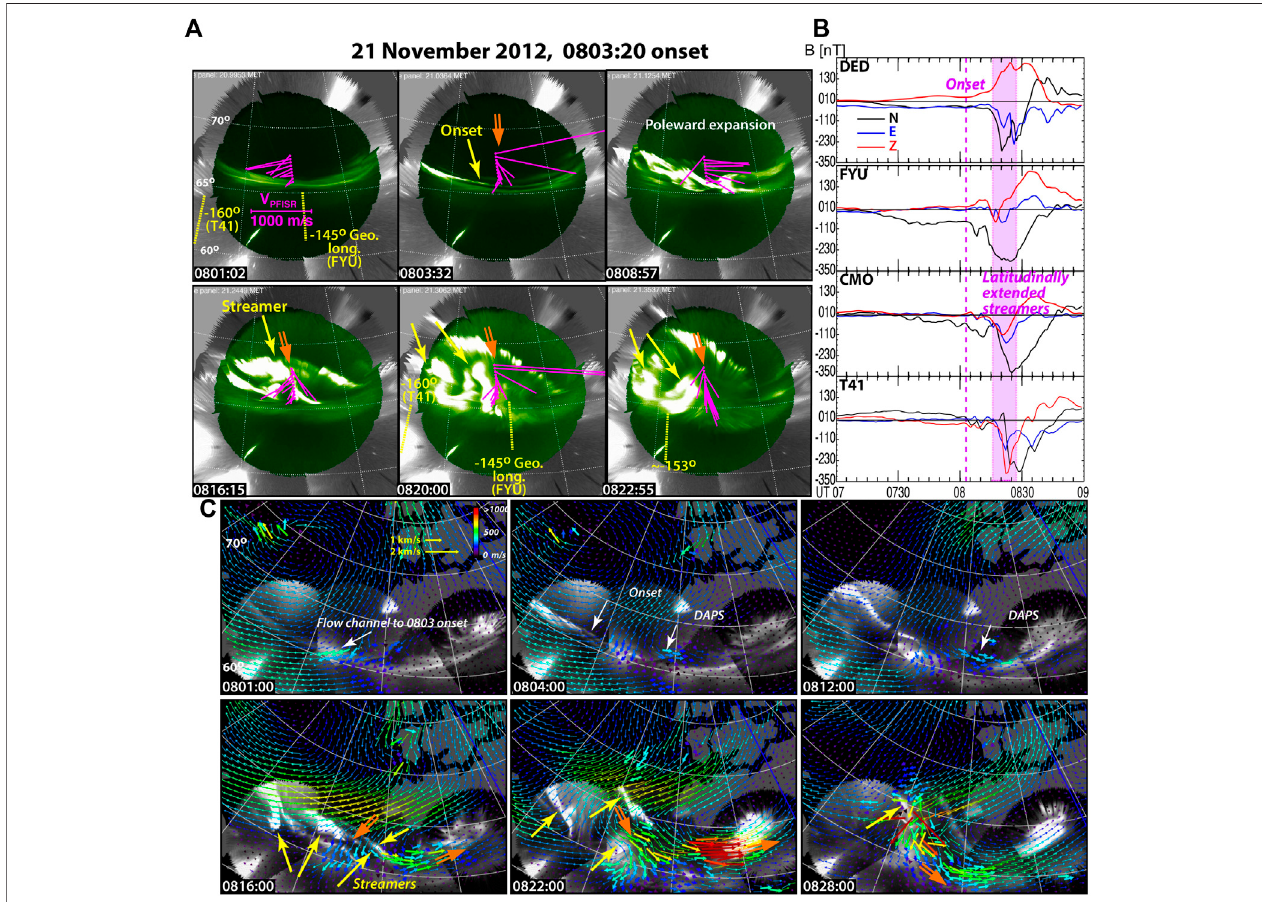
FIGURE7| Observations onNovember21,2012,duringaperiod whenPFISRwasoperating, andthereweresuf fi cientSuperDARNechoesavailableinregionsof interesttoprovide sometwo-dimensional fl owcoverage. (A) Poker FlatASI557.7 nm emissionswithTHEMIS ASIwhitelightemissions in regionsoutside thePoker Flat ASI FOV overlaid with PFISR fl ow vectors along the radar magnetic meridian. (B) Ground magnetometer observations from stations approximately along the Poker Flat meridianstackedfromlowertohigherlatitudes. (C) THEMISASImosaicsoveralargerareaoverlaidwithSuperDARN fl owvectors.Flowvectorsarescaledbycolor andlength,withthefootofthearrowbeingatthelocationofthemeasurement.Darkbluelineisthemagneticmidnightmeridian,andlongitudelinesarespaced15 ° apart. Heavier fl owvectorarrowsareatpointswithaLOS fl owmeasurement.Thefurtherfromaregionofheavierarrows,themorethe fl owsreverttoastatisticalmodel.Yellow arrows point toward streamers and orange arrows indicate observed streamer-related fl